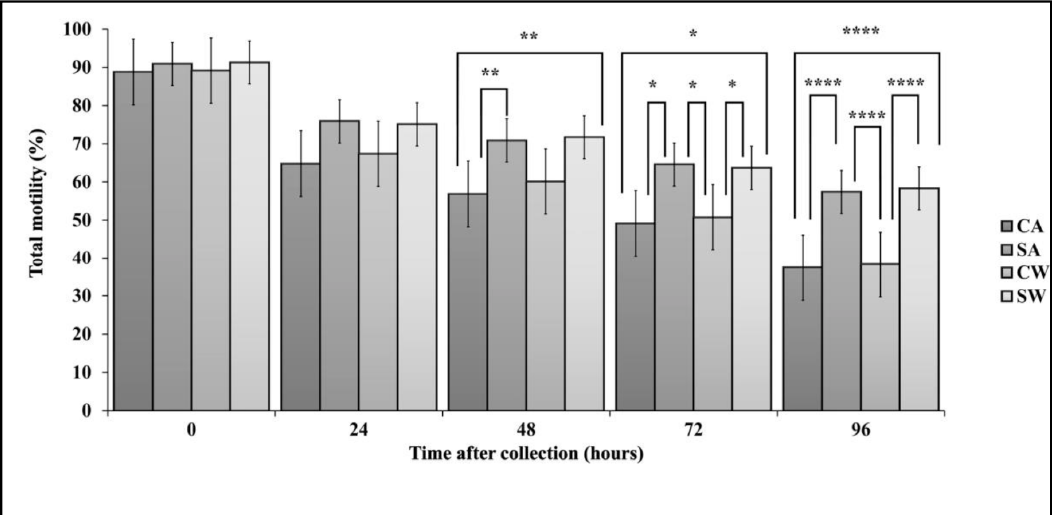
Figure 2. Total motility in control and MSLC samples, with and without antibiotics, during storage for 96 h at 6 ◦ C. Values are Least Squares Means ± SE ( n = 18). Note: * P < 0.05, ** P < 0.01, **** P < 0.0001. Abbreviations: CA, control with antibiotics; SA, modified single layer centrifugation with antibiotics; CW, control without antibiotics; SW, modified single layer centrifugation without